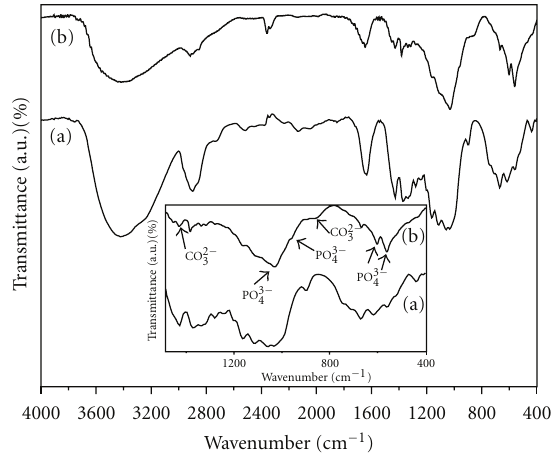
Figure 3: FTIR spectra of the BC (a) and BC-HA nanocomposites (b). Characteristic hydroxyapatite bands correspond to PO 3 − 4 and CO 3 − 2 ions (inset